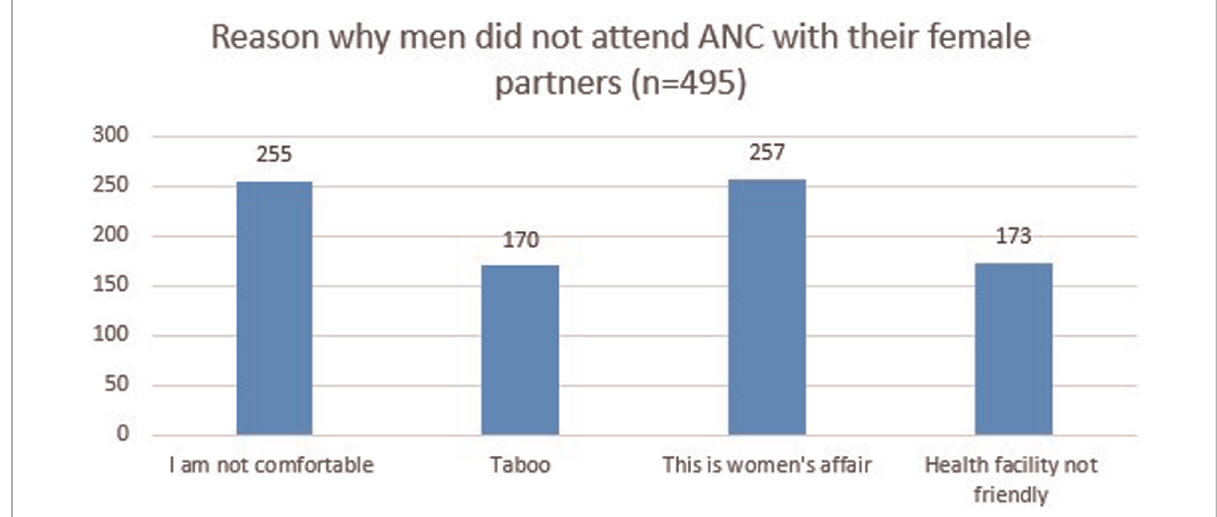
FIGURE 1 Reason why men did not attend ANC with their female partners in the Bench Sheko zone, Southwest region, Ethiopia, 2021. ANC, antenatal care.